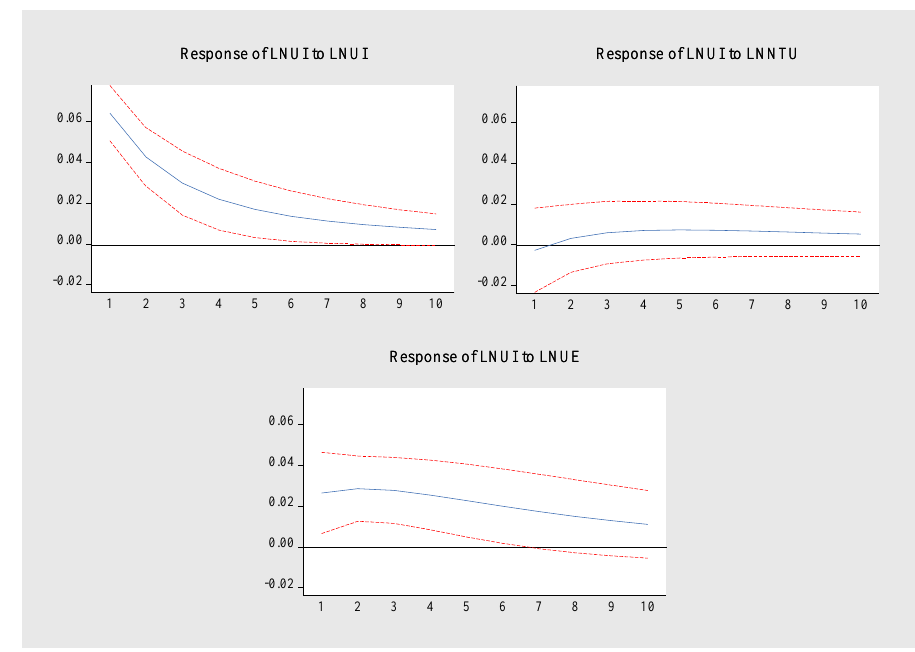
Figure 9. Pulse response diagram of LNNTU.